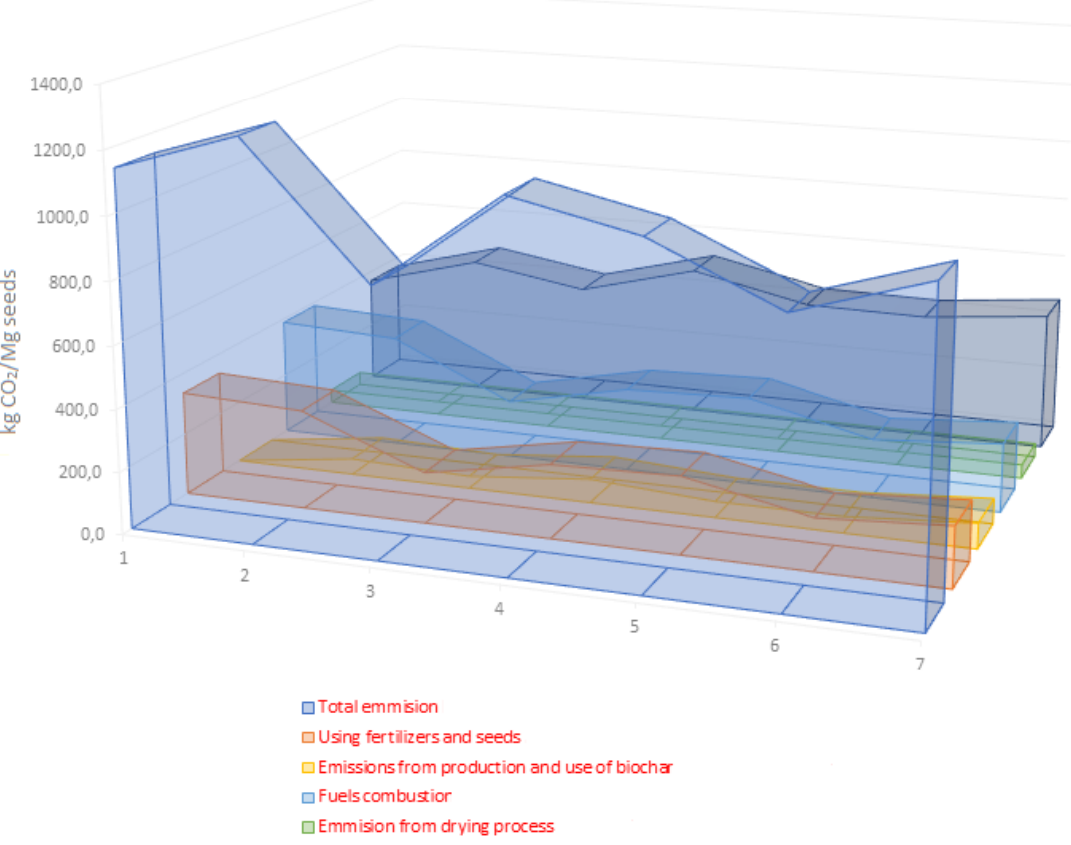
Figure 6. Share of individual emission sources in the total GHG emission related to soybean production (kg CO 2 /kg).